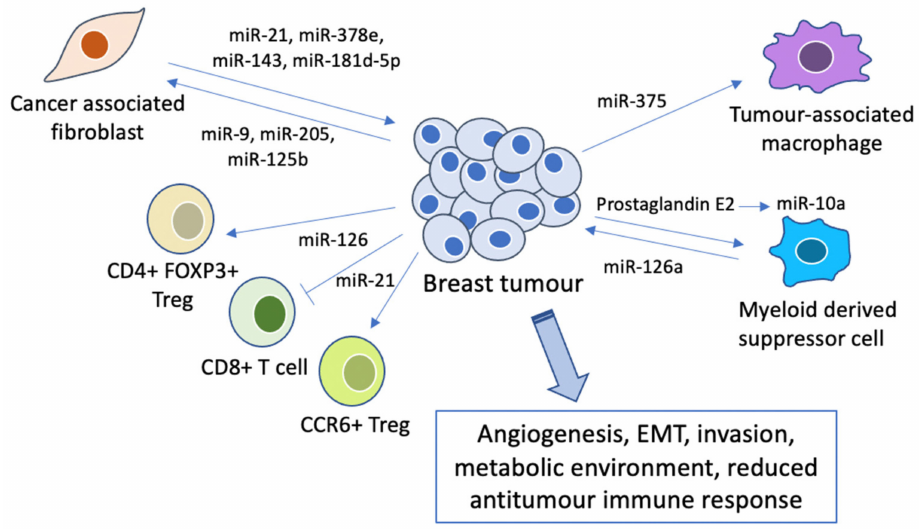
Figure 3. Crosstalk between breast cancer cells and stromal cells in the tumour